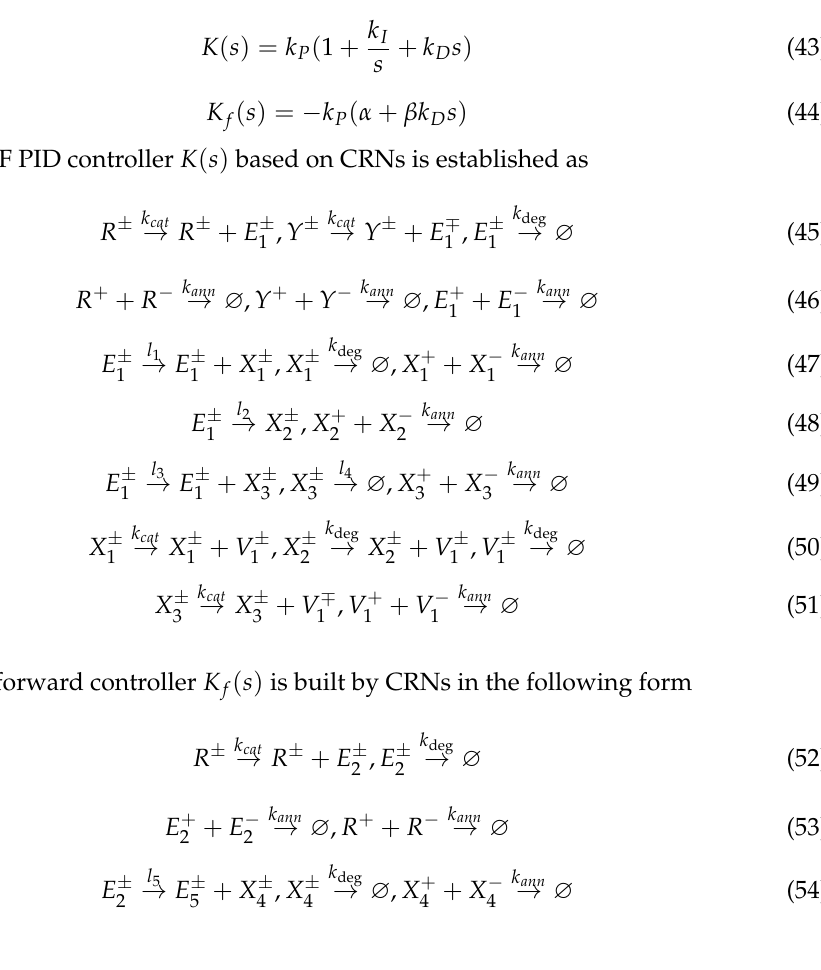
F . Figure 7. 2DOF PID control system F 3